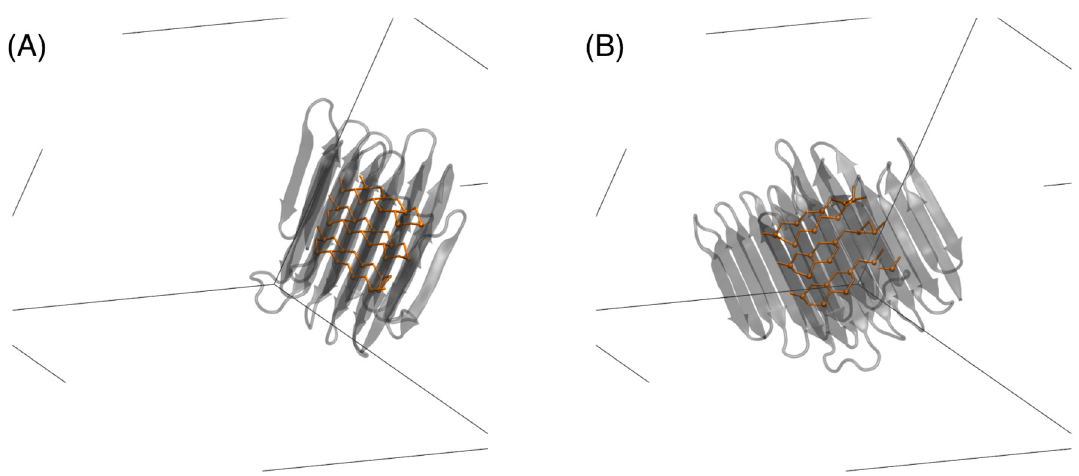
Figure 5. Instantaneous structures of Ri AFPs and water molecules between them, obtained at ( A ) the initial and ( B ) final steps of the 10 ns molecular dynamics (MD) simulation, for unrestrained proteins from the same viewpoints. A water molecule and an OH group of a Thr residue are connected by an orange line if their oxygen–oxygen distance is shorter than 0.34 nm. Gray lines represent the simulation box.